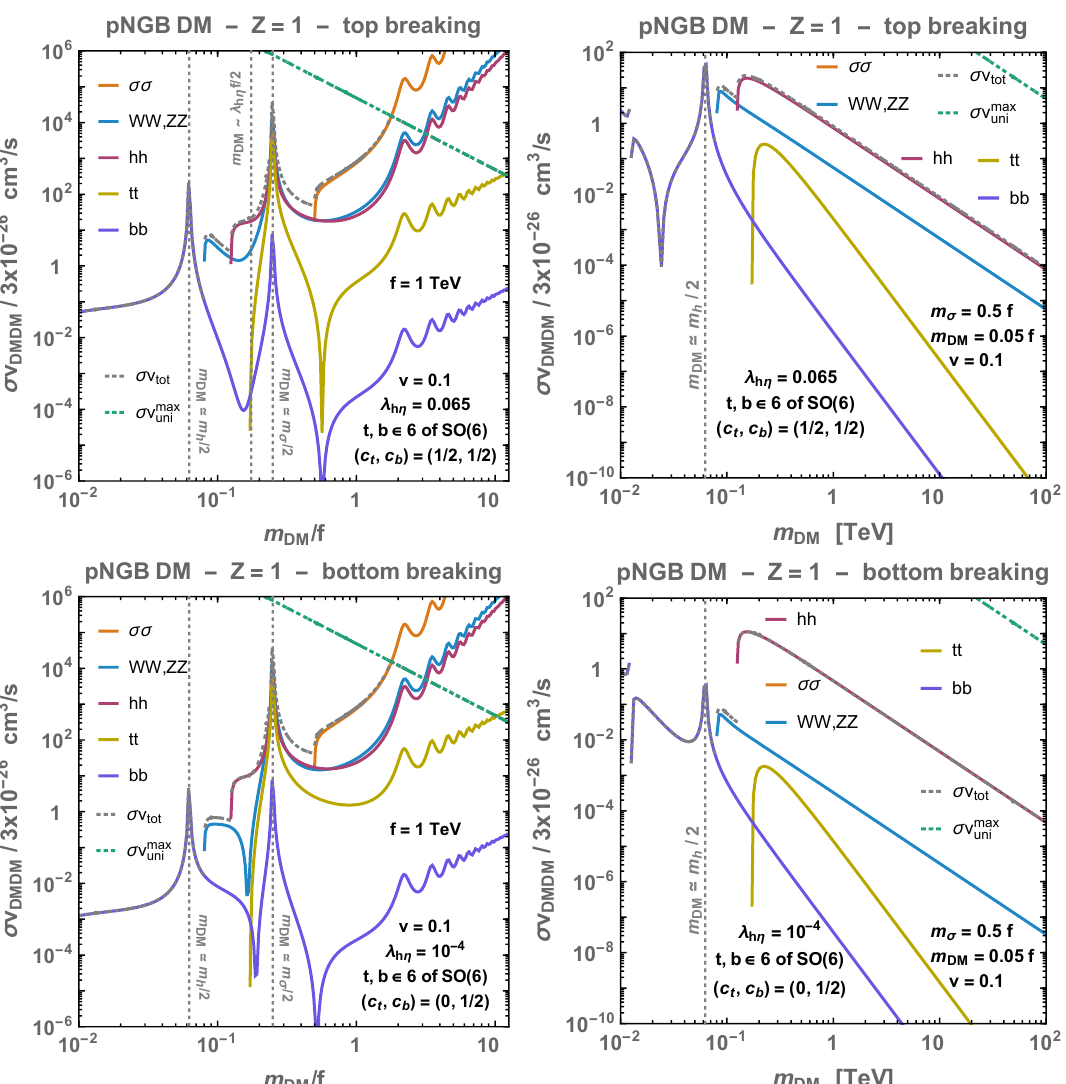
Figure 20 . DM annihilation cross-section in the scenario where DM is a O(6)/O(5) pNGB . We consider the pNGB shift symmetry to be explicitly broken either by the top interactions ( top ) or by the bottom ones ( bottom ). On the left panels, we fix the confining scale to f = 1 TeV while on the . In all plots, we set the dilaton mass to m = 0 . 5 f and the right panels, we fix it to f = 20 m σ DM relative velocity to v = 0 . 1 . The wiggles are consequences of Sommerfeld effects, cf. rel